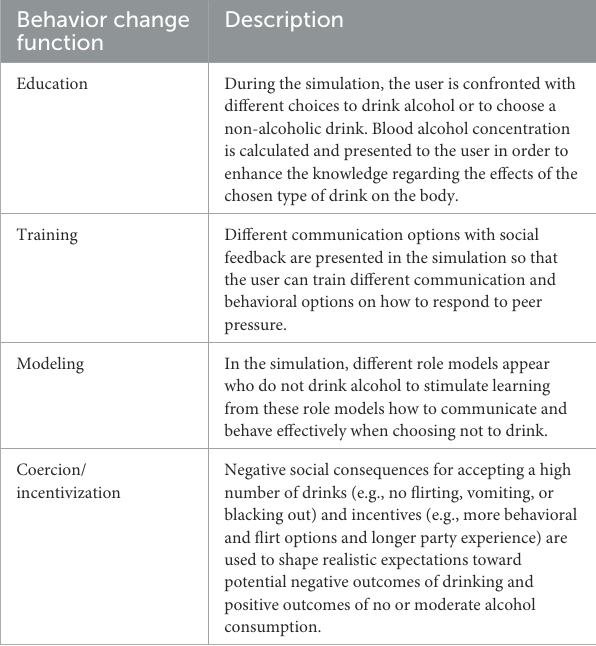
TABLE 1 Behavior change function in Virtual